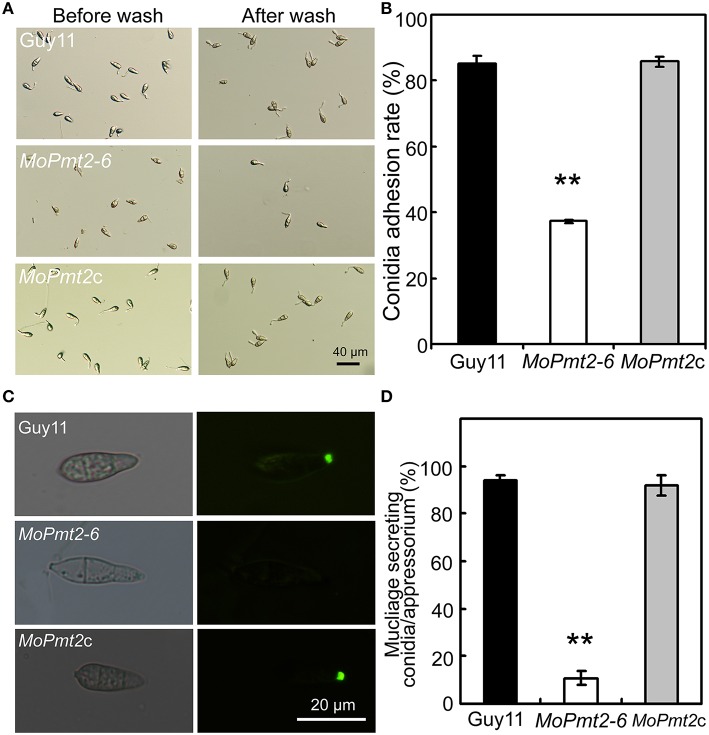
The effect of MoPmt2 on conidia adhesion. (A) Inability of MoPmt2 conidia to adhere to a hydrophobic surface. Conidia suspension of tested strains grew on a hydrophobic coverslips for 2 h was washed with sterilized water by pipetting and then visualized with brightfield optics of Nikon inverted Ti-S microscope. Scale bar = 40 μm. (B) Statistical analysis of conidia adhesion to hydrophobic coverslips. The numbers of conidia adhesive to the coverslips after wash were counted and statistically analyzed by Duncan's analysis (p < 0.01). Asterisks indicate significant differences of conidia adhesion among strains. Error bar represents standard deviation. (C) STM secretion test. STM from the conidia of Guy11, MoPmt2 mutant and MoPmt2c were stained with FITC-ConA, and the fluorescence signal from the germinated conidia were visualized by a Nikon inverted Ti-S epifluorescence microscope. (D) Statistical analysis of conidia stained by FITC-ConA. The numbers of conidia stained by FITC-ConA were counted and statistically analyzed by Duncan's analysis (p < 0.01). Asterisks indicate significant differences among strains. Error bar represents standard deviation.